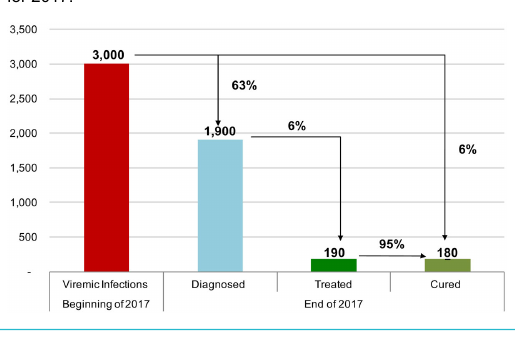
Figure 8: The hepatitis C cascade of care, including total viremic infections, diagnosed, treated and cured, in the canton of Geneva for 2017.